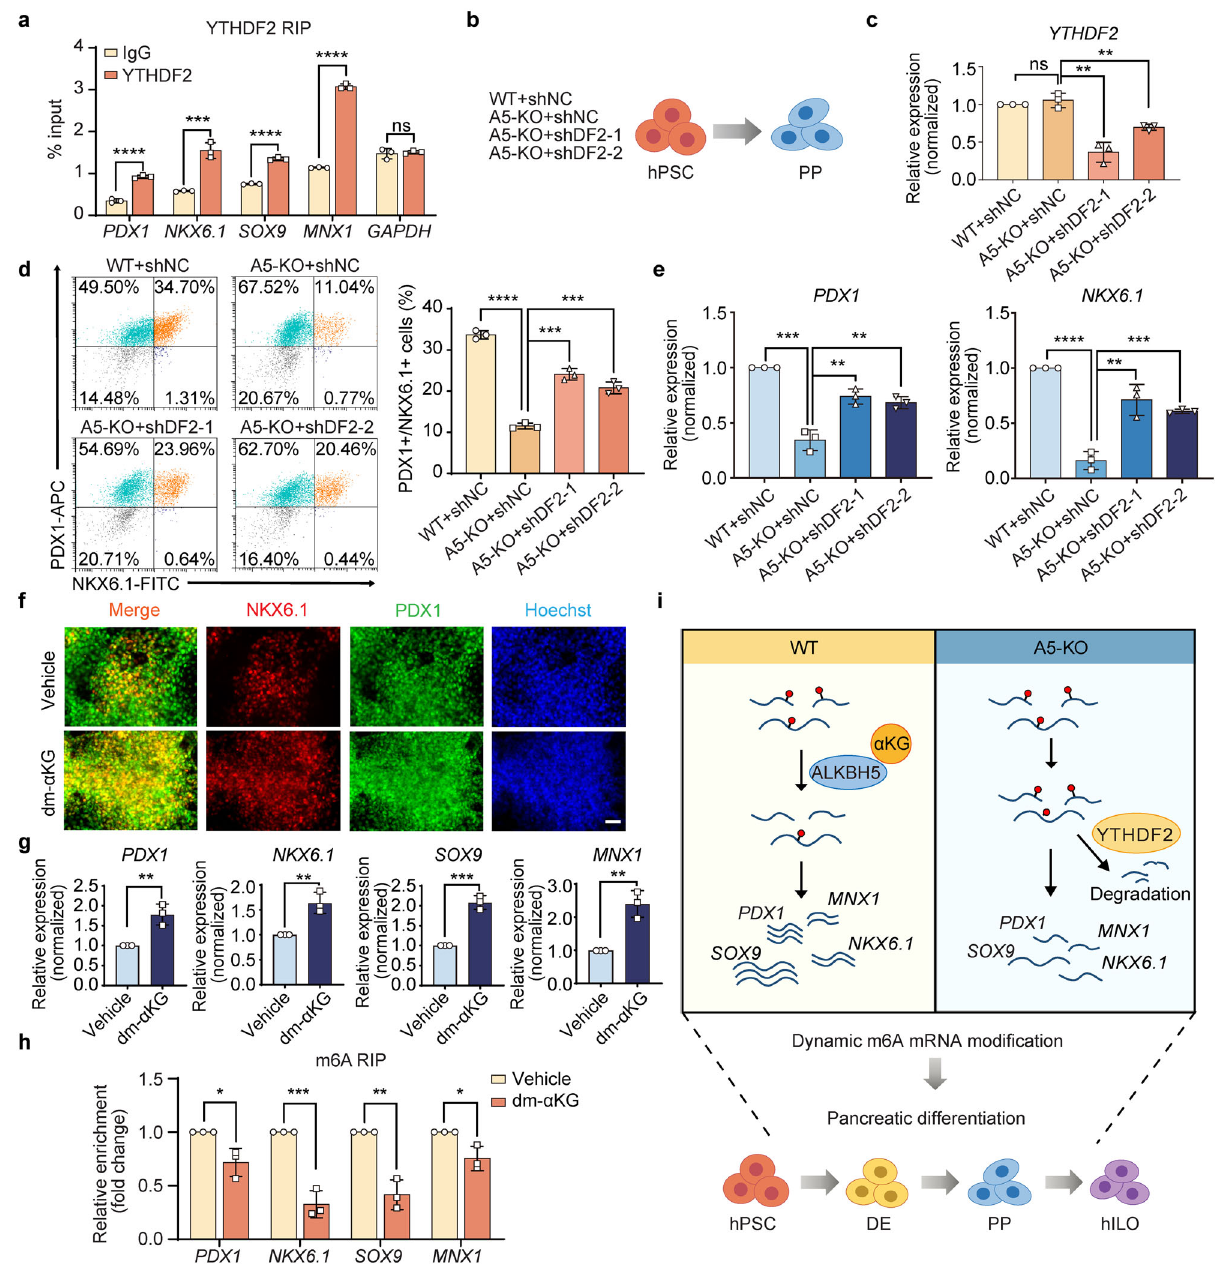
Fig. 7 YTHDF2 knock-down rescues and dm- α KG promotes human pancreatic differentiation. a RIP-qPCR analysis of the indicated mRNA transcripts bound with YTHDF2 in PPs ( n = 3 biological replicates). b A schematic representation of the generation of PPs from hPSCs. WT + shNC, A5-KO + shNC, A5-KO + shDF2-1, and A5-KO + hDF2-2 hPSC lines were used. c RT-qPCR analysis of the expression of YTHDF2 ( n = 3 biological replicates). d Representative fl ow cytometry plots and the percentage of PDX1 + NKX6.1 + cells in WT + shNC, A5-KO + shNC, and A5-KO + shDF2 PPs ( n = 3 biological replicates). e RT-qPCR analysis of PDX1 and NKX6.1 expression ( n = 3 biological replicates). f Immuno fl uorescent staining of PPs for PDX1, NKX6.1, and nuclei. Images are representative of three independent replicates. Scale bar, 100 μ m. g RT-qPCR analysis of PDX1 , NKX6.1 , SOX9 , and MNX1 expression ( n = 3 biological replicates). h RIP-qPCR showing the m 6 A enrichment decreased on indicated mRNA transcripts in PP populations treated with dm- α KG ( n = 3 biological replicates). i A schematic summary of functions and molecular mechanisms of ALKBH5 during human pancreatic speci fi cation and islet organogenesis. All data are presented as mean ± s.d. Statistical signi fi cance calculated using two-tailed Student ’ s t -test, ns p > 0.05, * p < 0.05, ** p < 0.01, *** p < 0.001, **** p < 0.0001. Source data are provided as a Source Data fi according to our previous protocol 13 . All plasmids (pcDNA3.1-hLbCpf1 (Addgene, Plasmid #31938), pCpfcr-cr1, and pCpfcr-cr2) were extracted by ZymoPURE Plasmid Maxiprep Kit (ZYMO). 1× 10 6 cells were resuspended with plasmid mixture and electroporation solution (Human Stem Cell Nucleofector Kit 1, Lonza)